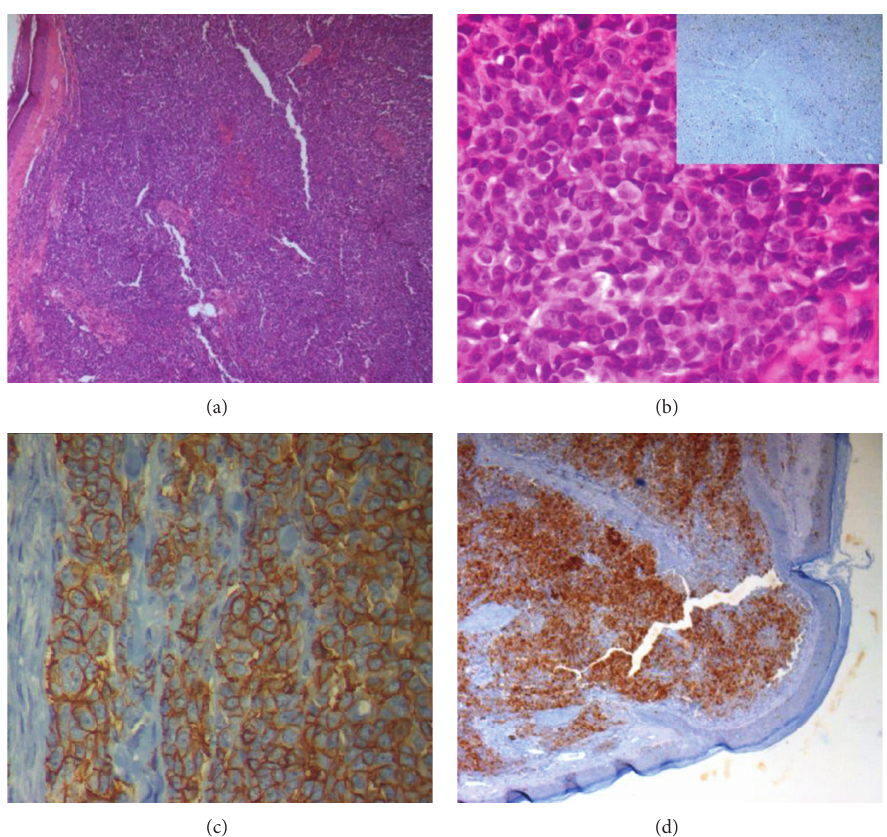
Figure 2: (a) Lobules of small, round, blue cells, separated by fibrous septa underneath an intact squamous epithelium (hematoxylin-eosin stain, objective original magnification × 5). (b) Higher magnification revealing tumor cells with scant, ill-defined cytoplasm and well-defined nuclei with coarse chromatin pattern (objective original magnification × 40), with a proliferation index superior to 15% (Ki-67 stain at the upper right corner). (c) Immunohistochemical membranous cytoplasmic stain for CD99 (objective original magnification × 40). (d) Immunohistochemical stain for S-100 (objective original magnification ×